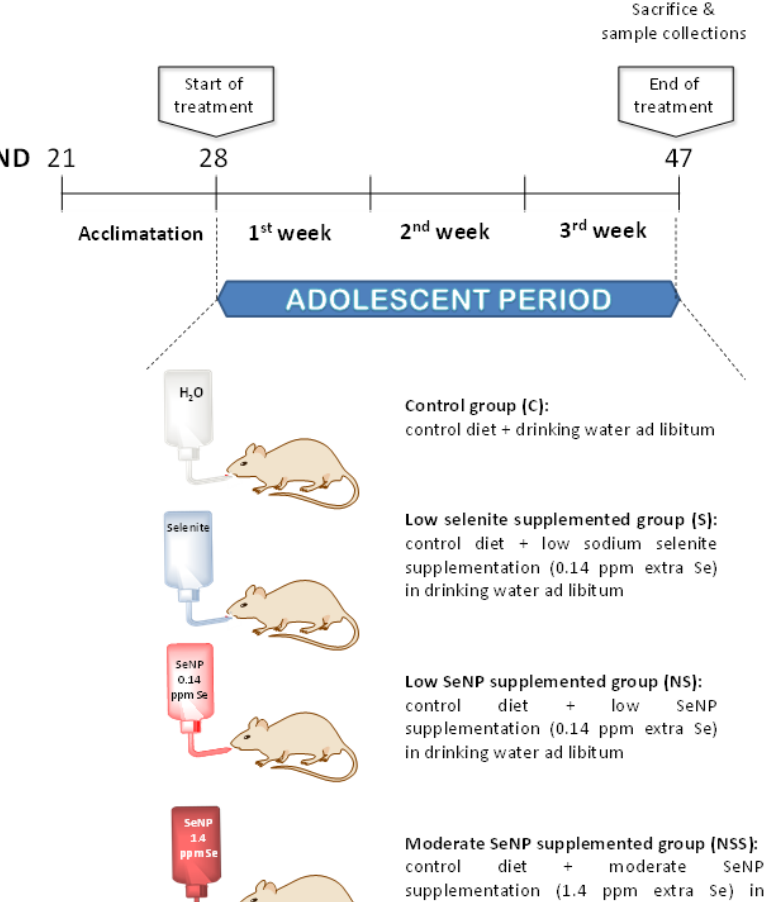
Figure 1. Experimental design of the study. The standard pellet diet (LASQCdiet ® Rod14-R; Märkische, Germany) that contained 0.20 ppm of Se in the form of sodium selenite was available ad libitum in all experimental groups. Low-Se-supplementation groups (S and NS) received 0.14 ppm extra Se as anhydrous sodium selenite (Panreac, Barcelona, Spain) and SeNPs (devoloped at the